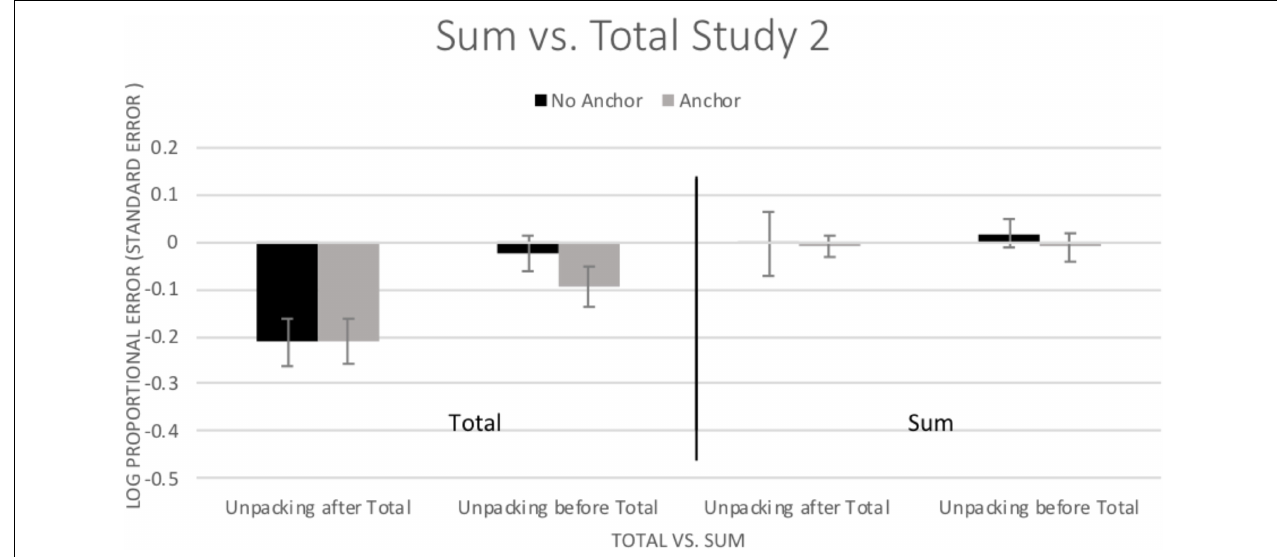
FIGURE 4 | Mean ( ± 1 SE ) bias in estimated duration (log of estimated duration/actual duration) for the total duration estimation and for the sum of the segments. Positive values indicate overestimation and negative values indicate underestimation.